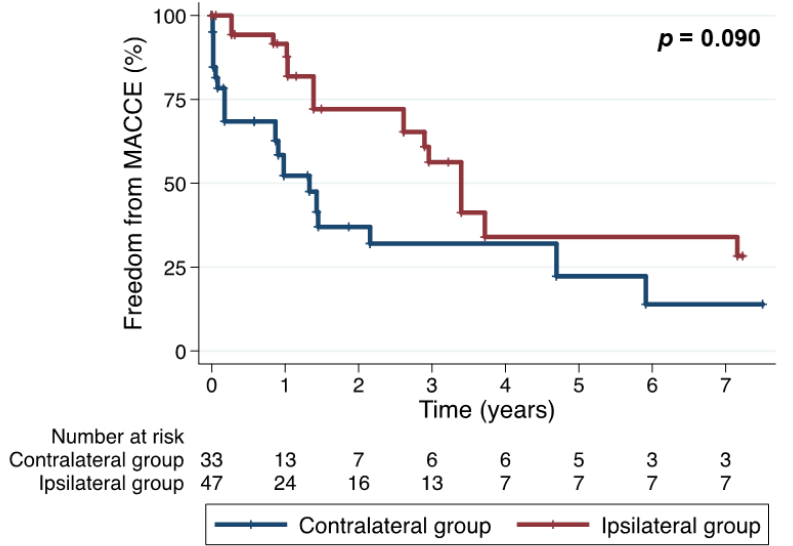
Figure 3. Freedom from major adverse cardiovascular and cerebrovascular events (inverse probability weighting-adjusted comparison).